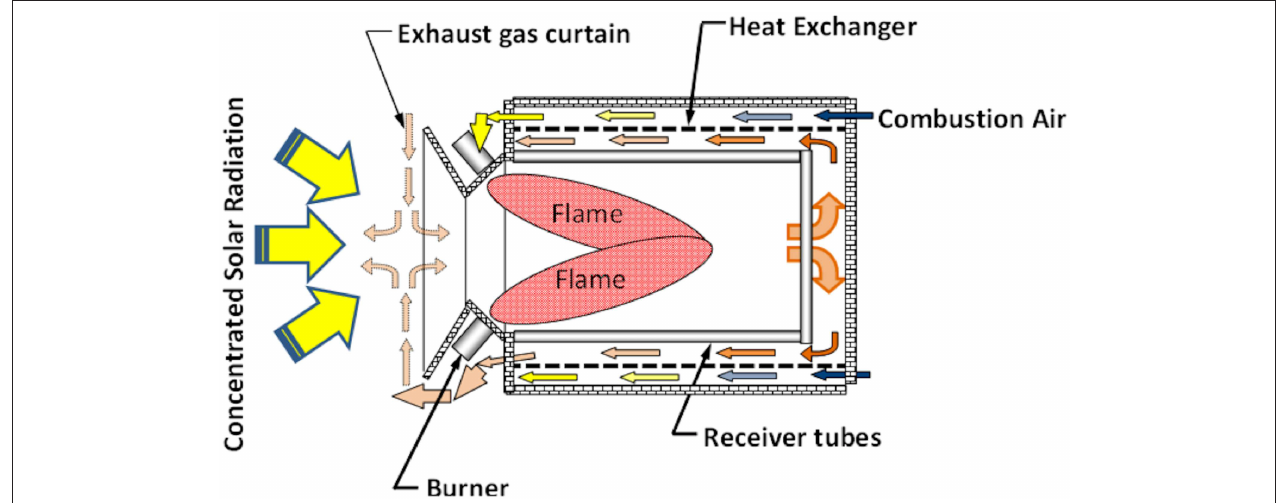
FIGURE 1 | Schematic diagram of the conceptual design of the Hybrid Solar Receiver Combustor, HSRC. Adapted from Lim et al.